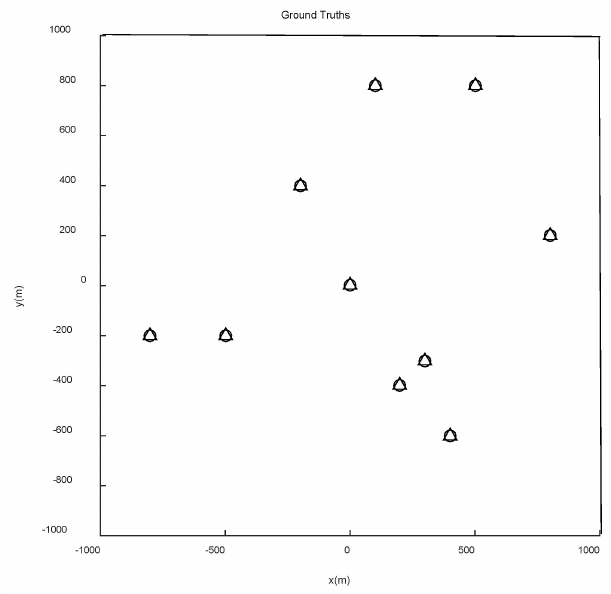
Figure 3. The true position of the feature points in the